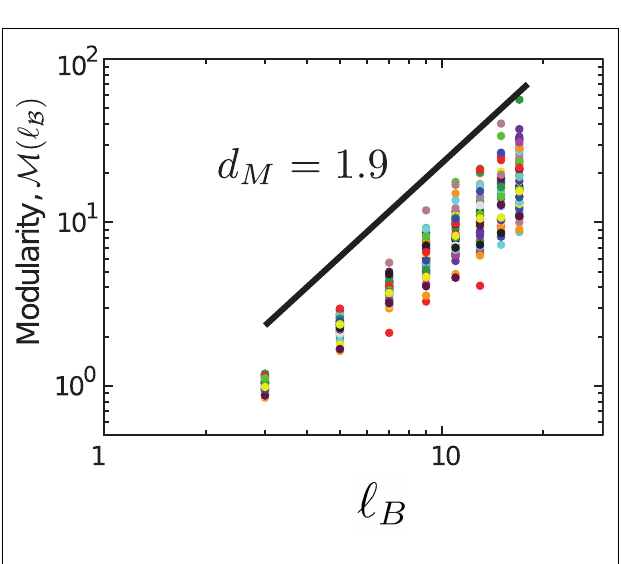
FIGURE 6 | Consistency of the fractal dimension calculations. (A) Cross-plot of d f vs d B for individual brain clusters.The colors correspond to the threshold values of p c where the first percolation transition was identified. (B) The network fractal dimension, d f